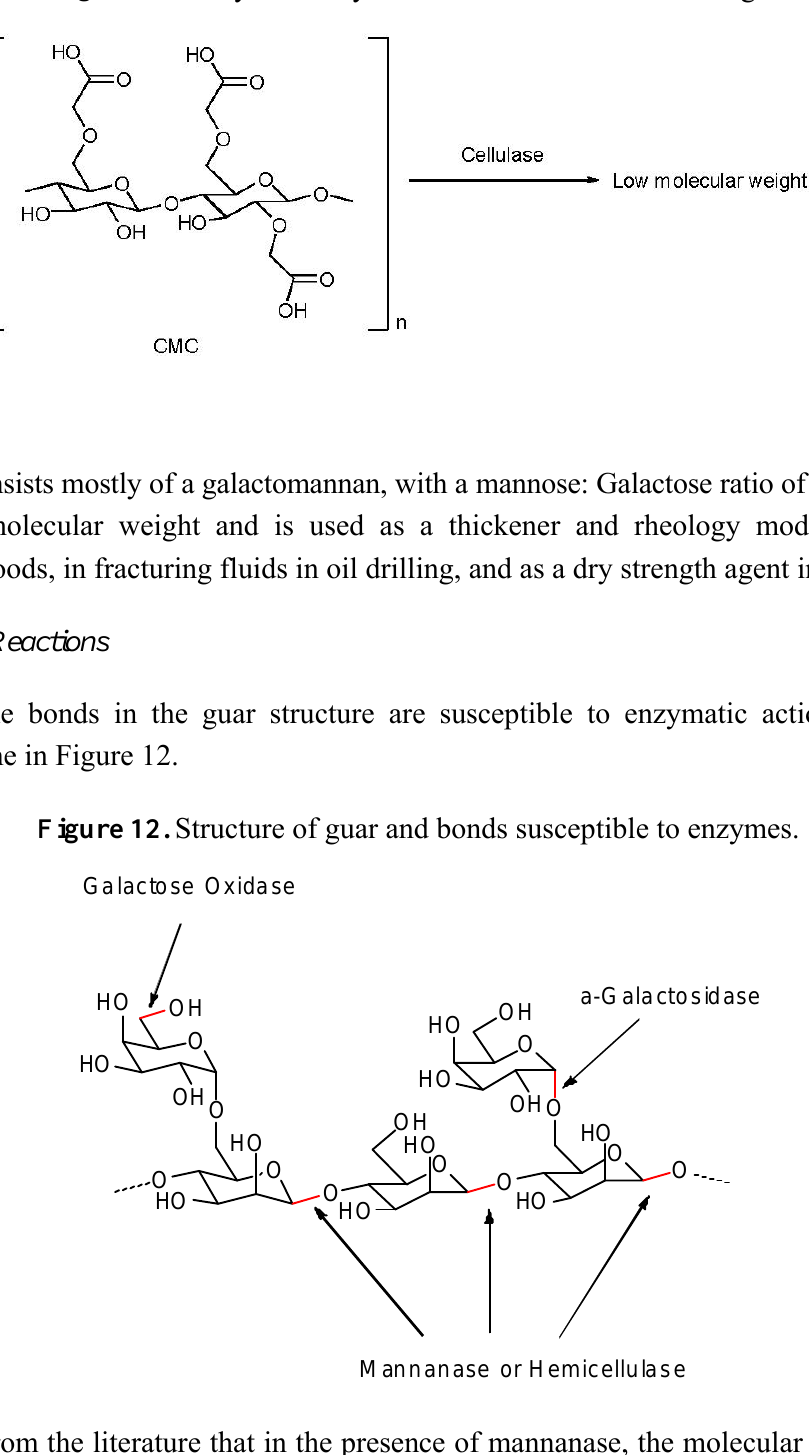
Figure 11. Enzyme-catalyzed reduction of molecular weight.